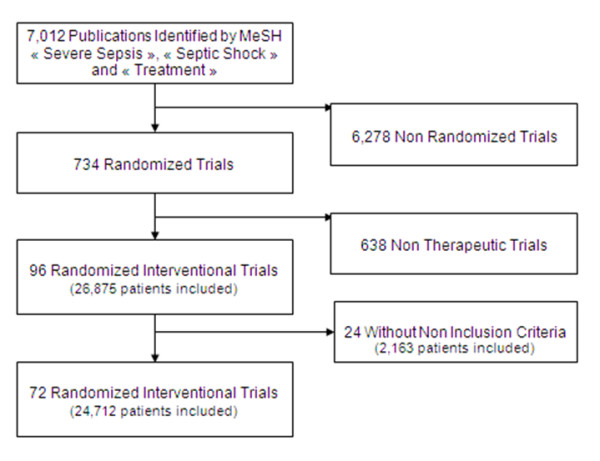
Flow diagram of screened, eligible, and included randomized controlled trials, and number of patients included.